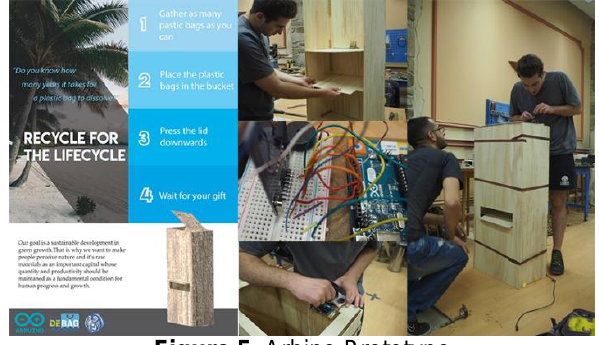
Figure 5. Arbino Prototype